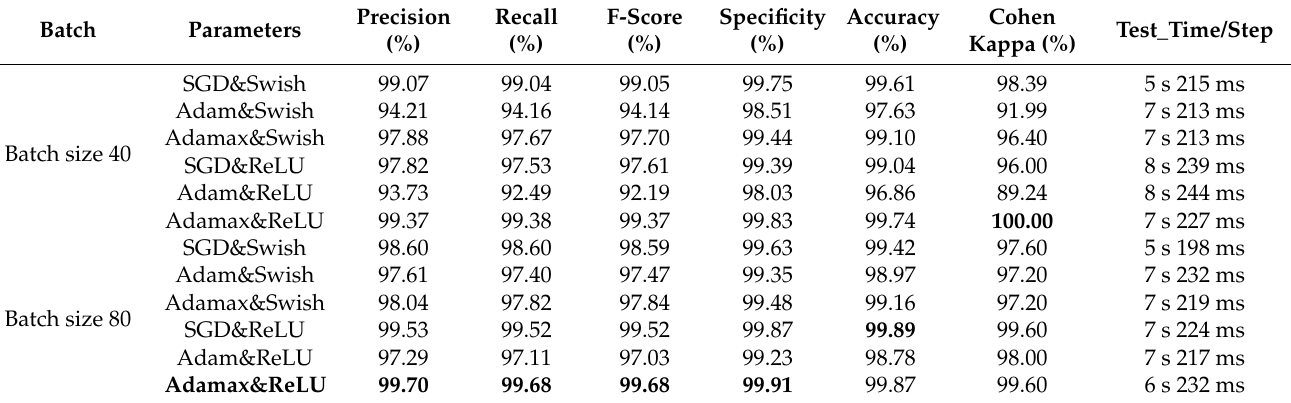
Table 3. The performance of the proposed model using different hyper-parameters.